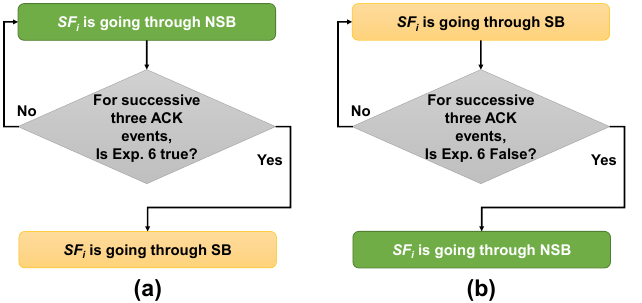
Figure 5. Flowchart on the decision process on whether an SF ( a ) considering an SF i is currently going through an NSB, and ( b ) considering an SF i is currently going through an